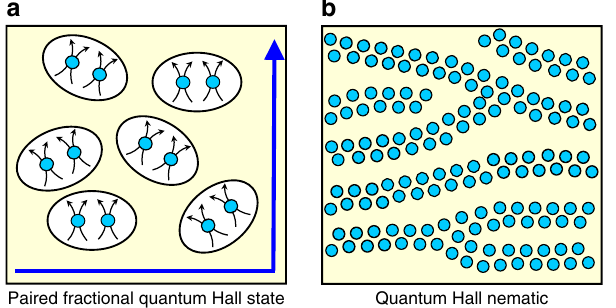
Fig. 1 Schematic of the ordered phases at even denominator fi lling factors. a The paired FQHS consists of Cooper pairs of composite fermions and possesses edge states 22 – 25 . Composite fermions are depicted as electrons with two magnetic fl uxlines attached 20 . b The quantum Hall nematic is a fi lamentary electronic phase, which breaks rotational symmetry